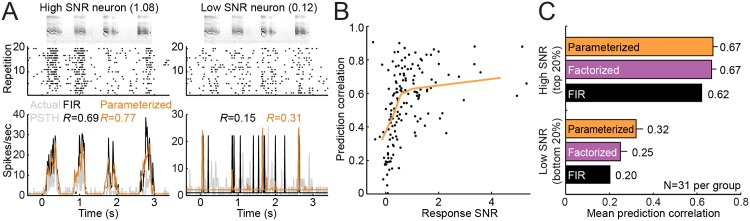
Model performance versus neuronal signal-to-noise.
A. Example data for two neurons with high (left) or low (right) response SNR. A validation stimulus (spectrogram, top) was presented over 20 repetitions (raster response, middle). Both the FIR and parameterized STRFs were able to predict activity of the high-SNR neuron more accurately than the low-SNR (predicted versus actual PSTHs, bottom). However, the relative improvement for the parameterized STRF was greater for the low-SNR neuron (prediction correlations shown, R). B. Scatter plot compares signal-to-noise ratio (SNR, estimation data) against prediction correlation (validation data) by the parameterized model for each A1 neuron. Orange line plots the average for data grouped in quintiles according to SNR, showing a correlation (R = 0.45). C. Average prediction correlation for the FIR, factorized, and parameterized models separately for top and bottom quintile of neurons, ranked by response SNR. The factorized and parameterized models show greater improvement over the FIR model for the low-SNR neurons than the high-SNR neurons.